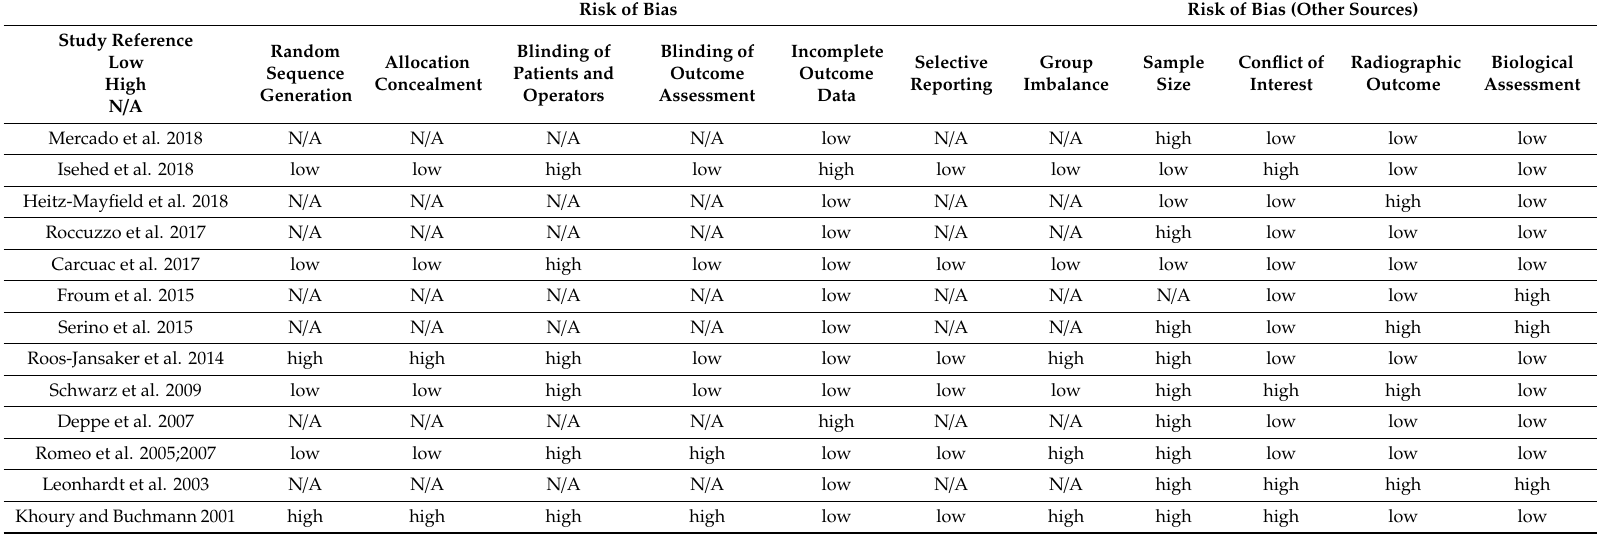
Table 1. Quality assessment of the included studies according to the Cochrane risk of bias tool. Characteristic, quality, and heterogeneity of enrolled studies were